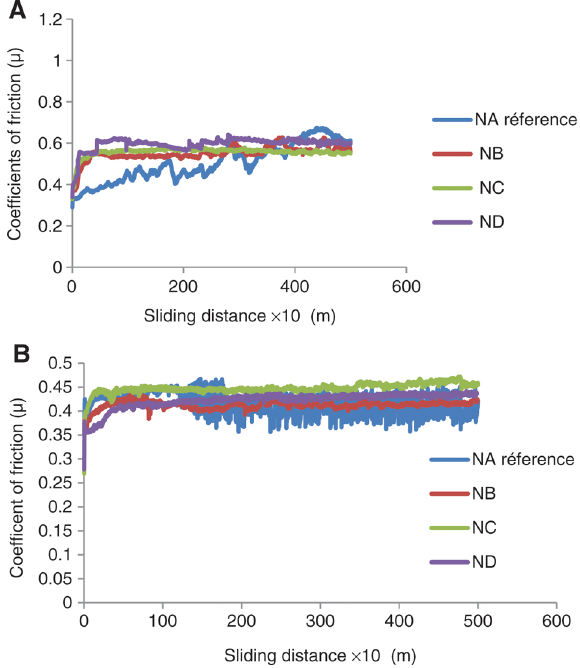
Figure 7: Comparison of the variation of the (COF) of different grades according to the reference grade (NA) for the two temperature:(A) (P1) (450°C), (B) (P2) (650°C) for a distance travelled (5000